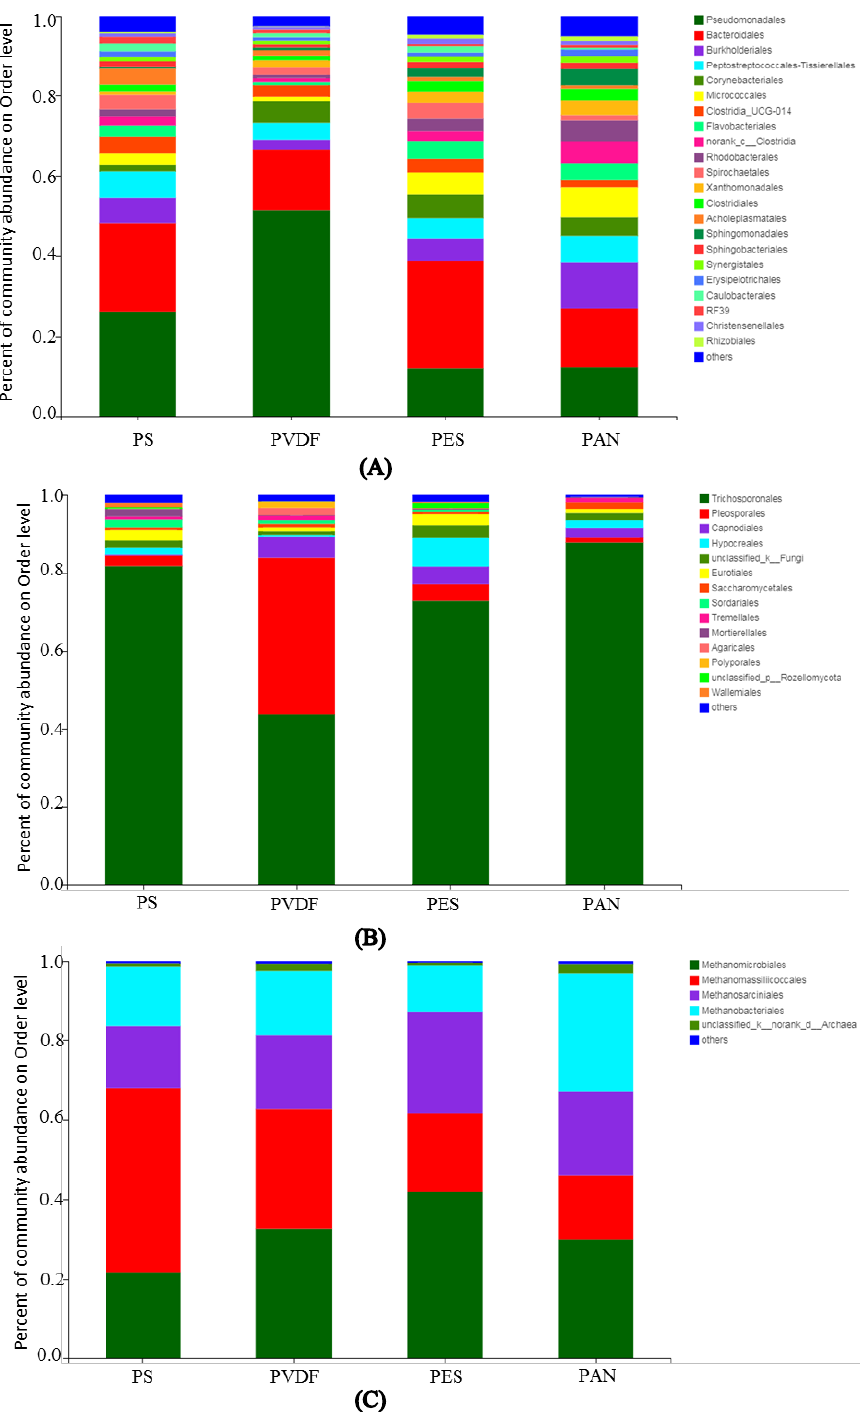
Figure 6. Microbial community abundances of: ( A ) bacteria; ( B ) fungus; ( C ) archaea on membrane fouling.